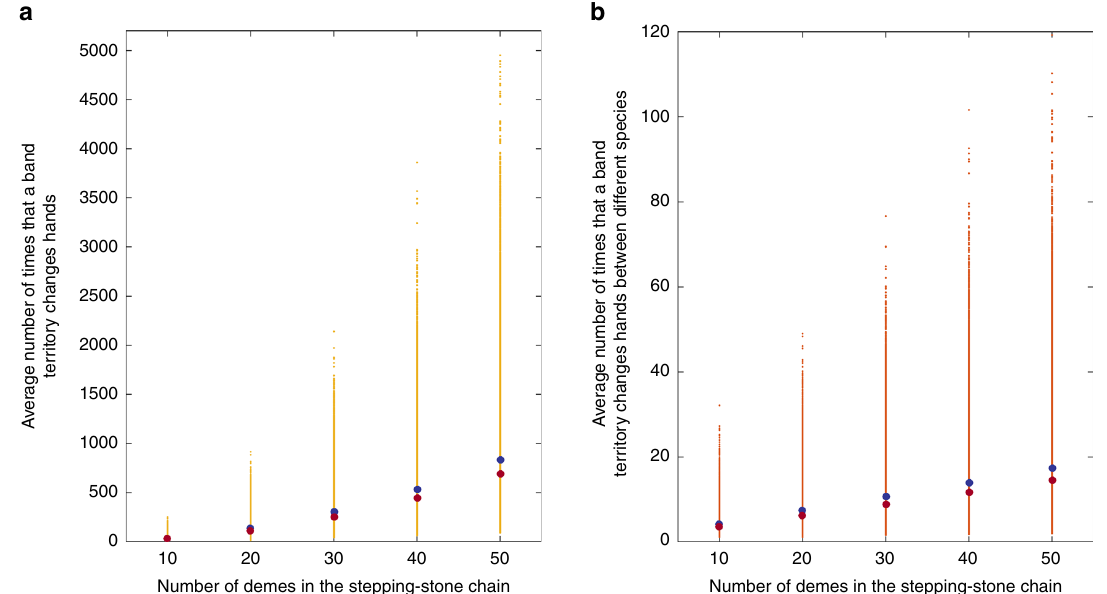
Fig. 6 Band replacements in the spatially explicit model. The mean (dark blue) and median (brown) of the mean number of times that a band territory changes hands during the species replacement process. Panel a depicts these values for both band replacements that occur between bands of the same species and bands that are not of the same species. Panel b depicts these values for inter-species replacements only. 50,000 simulations were conducted for each value of the number of demes in the stepping-stone